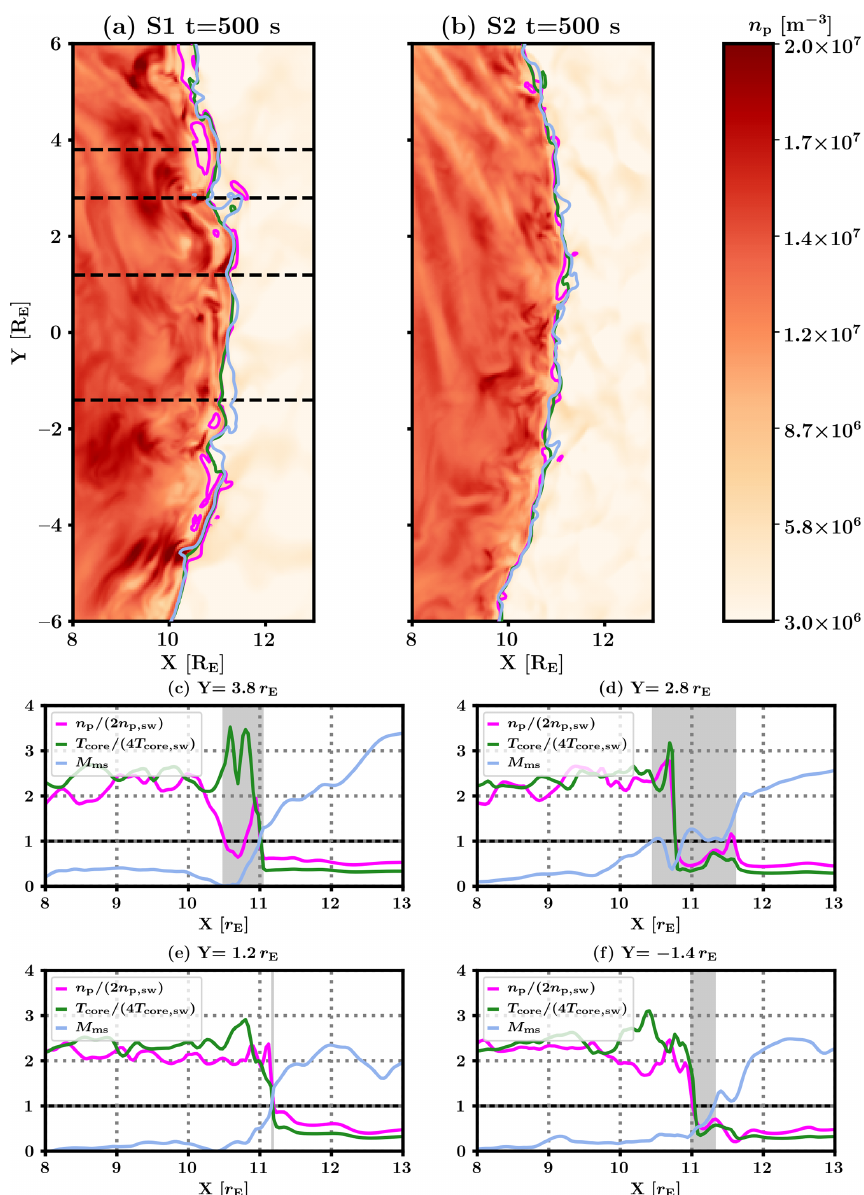
Figure 2. Proton number density overlaid with bow shock positions according to criteria for plasma density (fuchsia, n p = 2 n p , sw ), solar wind core heating (green, T core = 4 T sw ), and the magnetosonic Mach number (pale blue, M ms = 1). Panel (a) is for S1 ( B sw = 5nT); panel (b) is for S2 ( B sw = 10nT). Both are at t = 500s. Panels (c) – (f) show line profiles of the three bow shock criteria along the dashed black lines shown in (a) , corresponding with differing amounts of shock